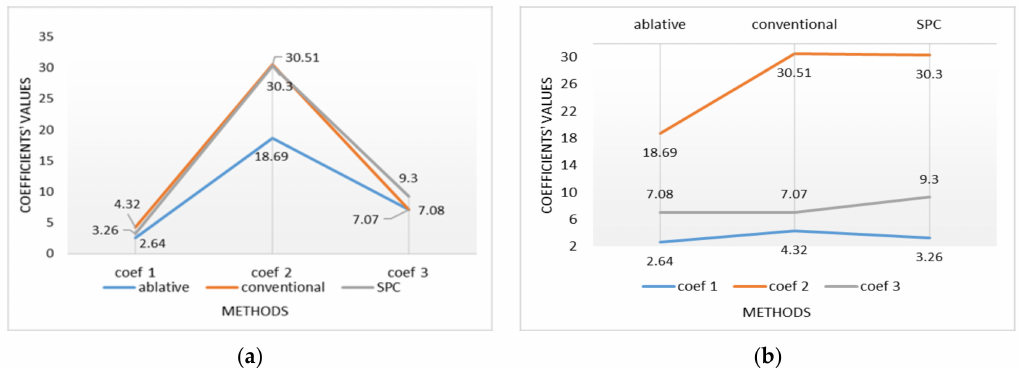
Figure 3. Representation of the ratio of emissions derived from the ratio of applied methods: ( a ) from coe ffi cients; ( b ) from AF coatings. Y-axis shows non-dimensional value of derived coe ffi